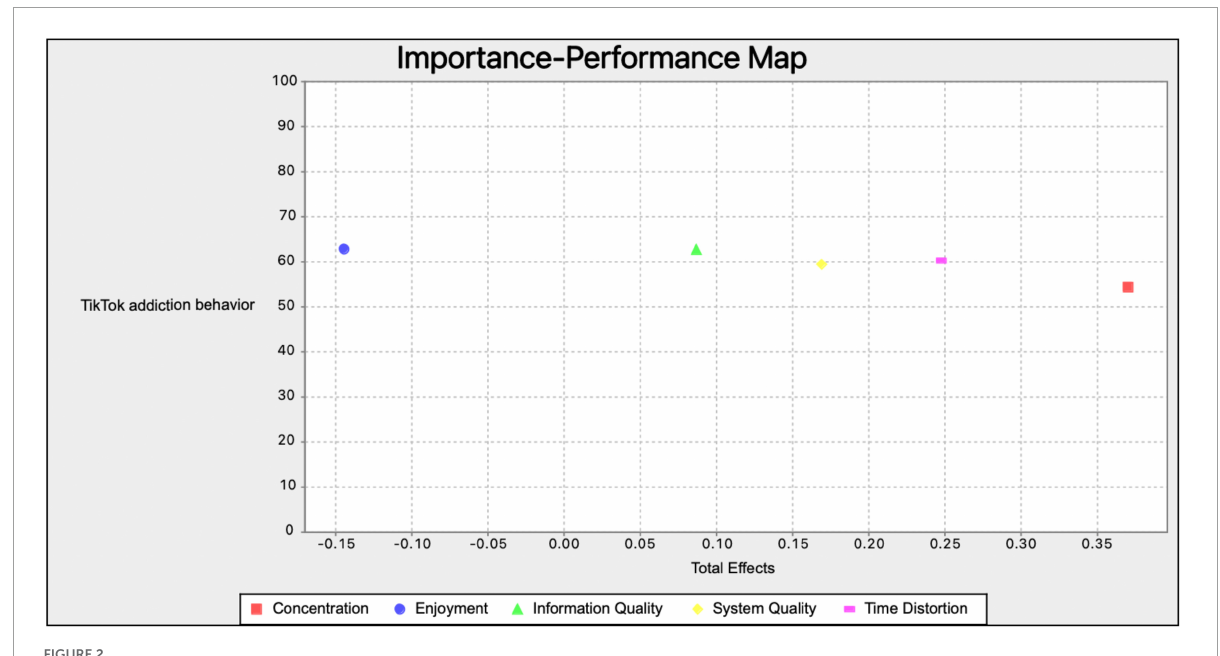
FIGURE2 Importance–performance map of TikTok addiction